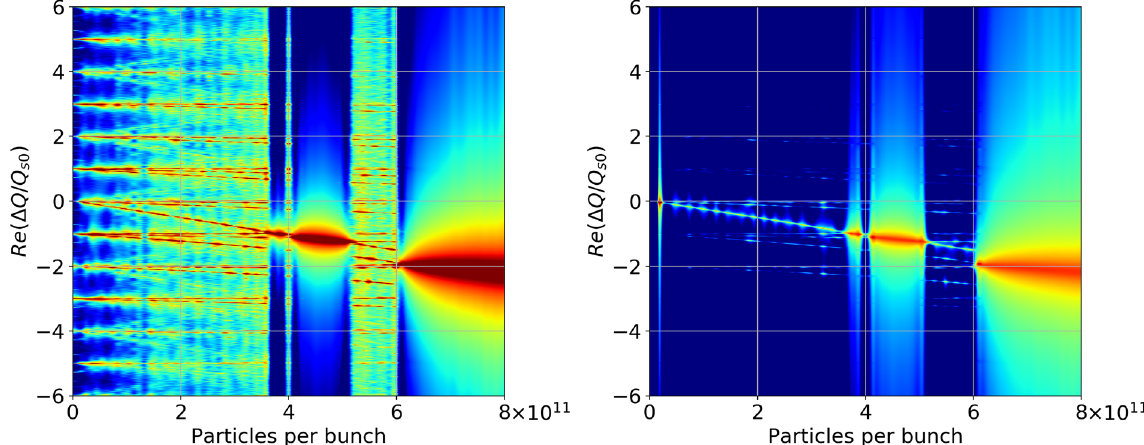
FIG. 9. Real part of normalized mode-frequency shift obtained with the results of P y HEADTAIL with a transverse BBR impedance. The left-hand side has been obtained by summing the first ten modes, the right-hand side has been obtained by using only M 0